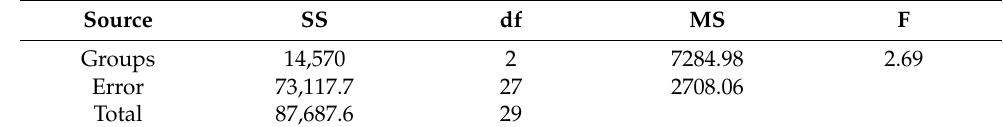
Table 4. One-way ANOVA results.